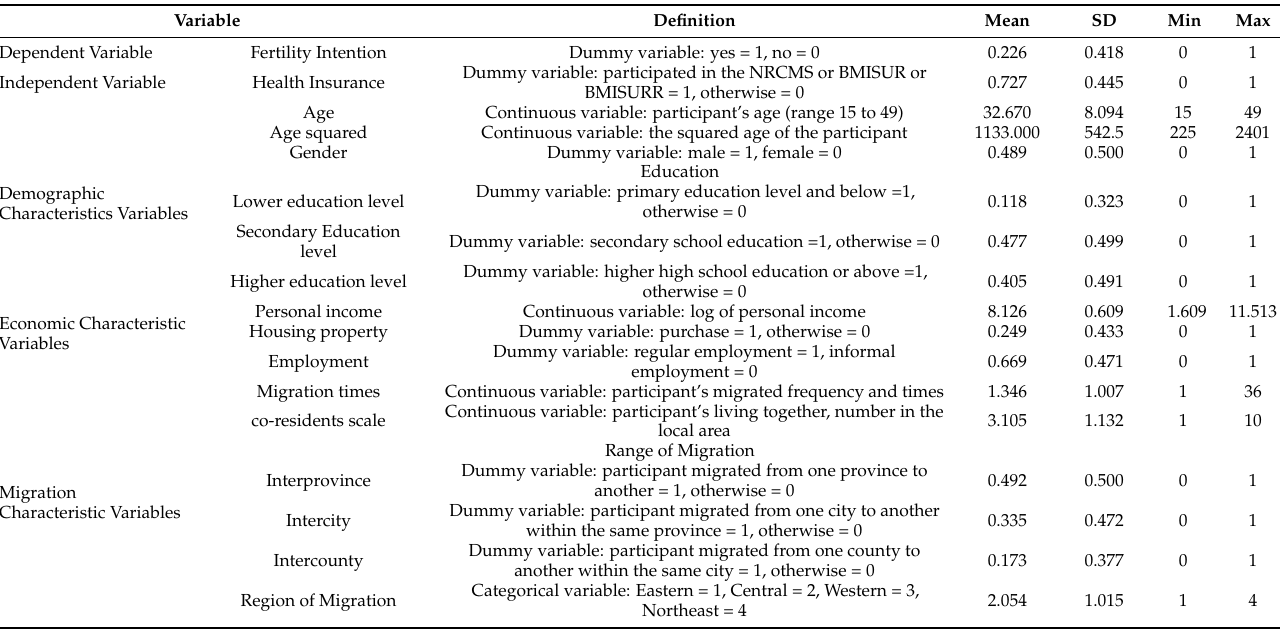
Table 1. Definitions of variables and description of the